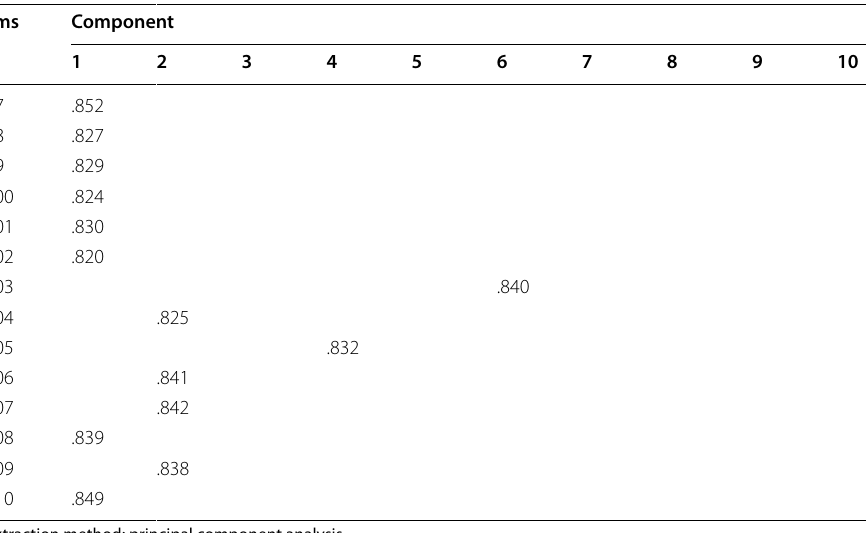
A extraction method: principal component analysis A rotation method: varimax with Kaiser